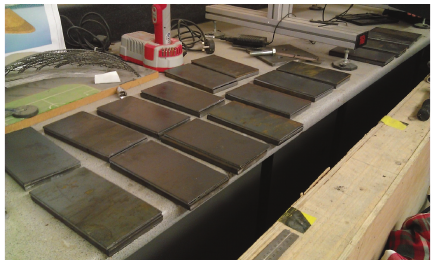
Figure 13: Steel bearing plates prior to drilling.